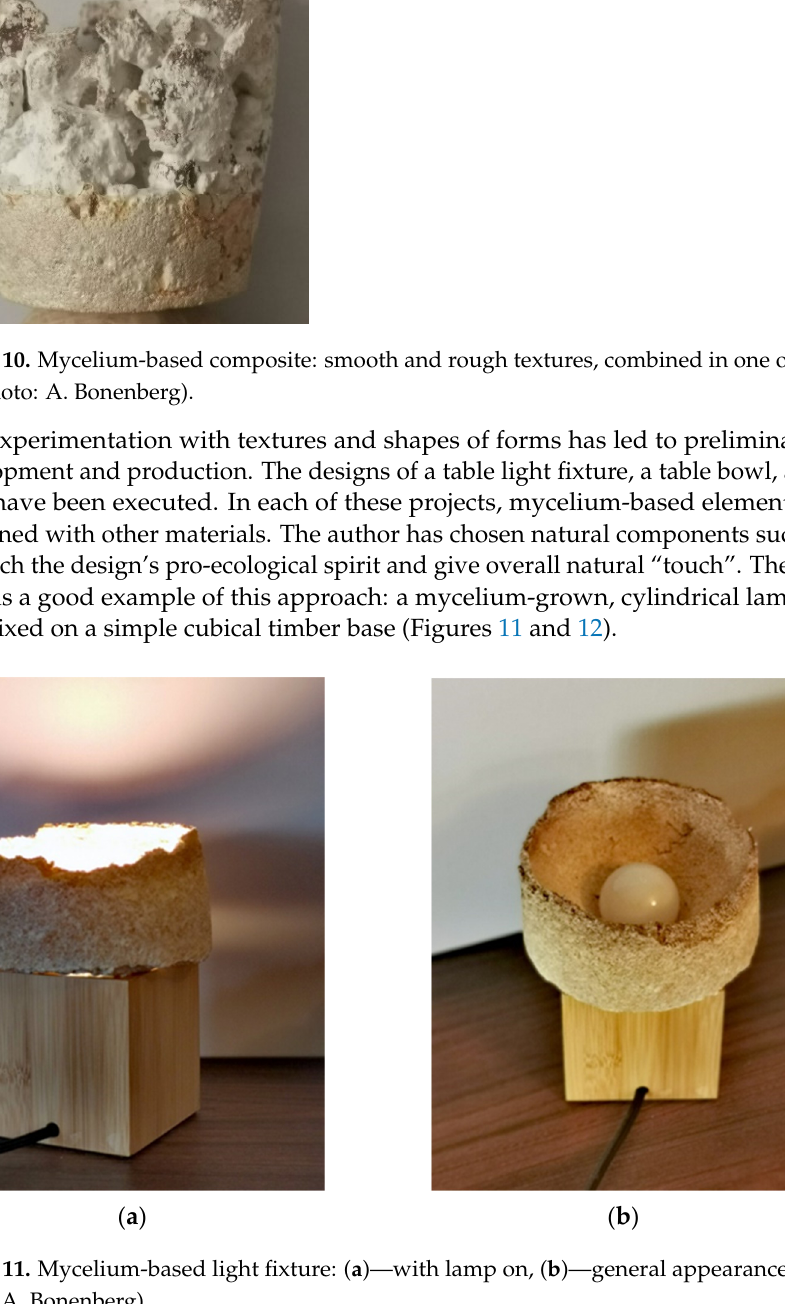
and photo: A. Bonenberg).